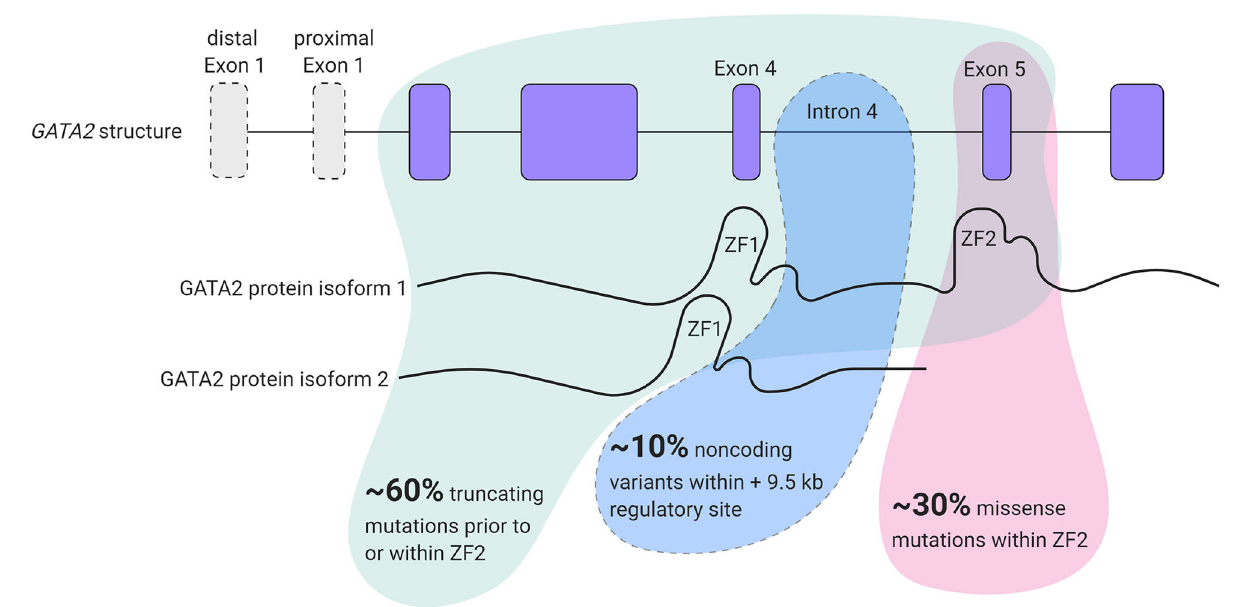
FIGURE 1 | GATA2 locus organization and overview of mutation types found in GATA2 haploinsufficiency